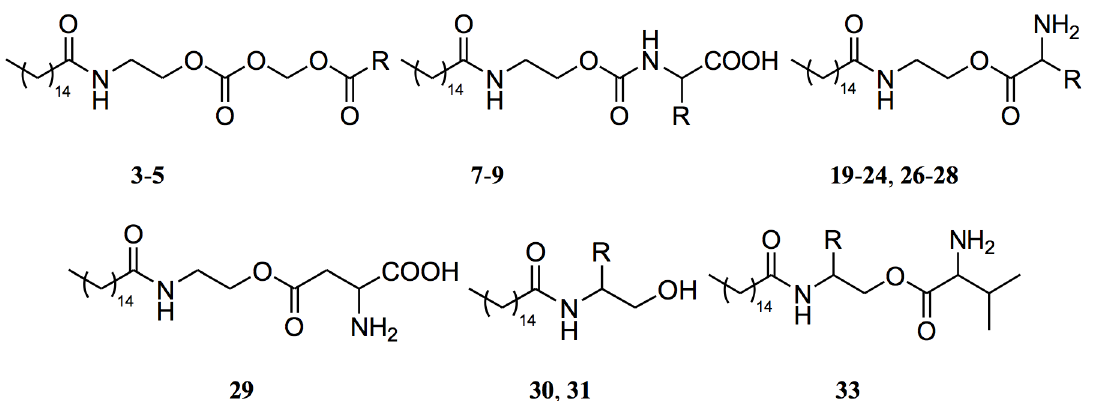
Fig 2. General formulas of PEA prodrugs reported in Table 1.